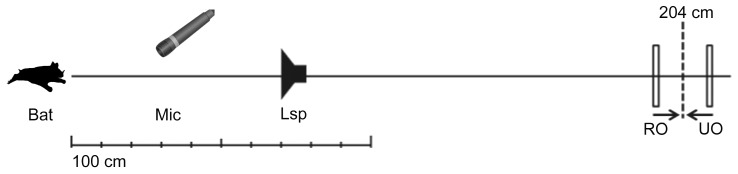
Illustration of real and virtual objects in the Distance-discrimination control experiment.Virtual objects were generated by delaying and attenuating the sounds picked up by the microphone and playing these from the speaker. Thus, the virtual object appears behind the speaker-microphone combination at a distance of 204 cm. The bats were trained to discriminate a distance difference of 17 cm, as indicated by the vertical bars (RO: −8.5 cm; UO: +8.5 cm). Upon successful training, the distance difference was progressively decreased until a threshold could be extracted.